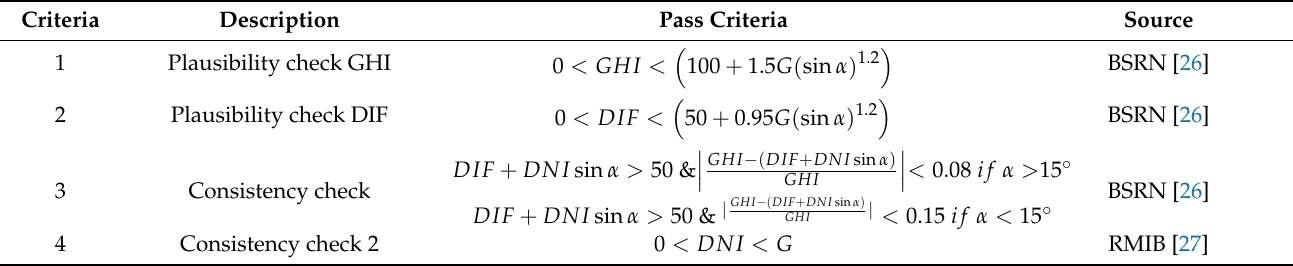
Table 2. Quality control criteria used for data assessment.